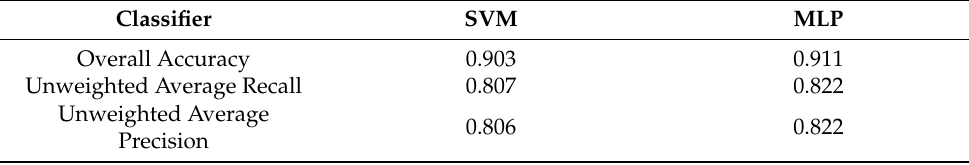
Table 3. Average scores in multi-class classifications, eGeMAPS feature